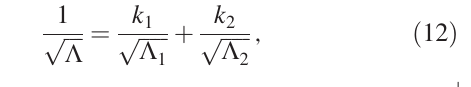
ffiffiffiffiffiffiffiffiffi p 1 = Λ ¼ 0 . 75 ,